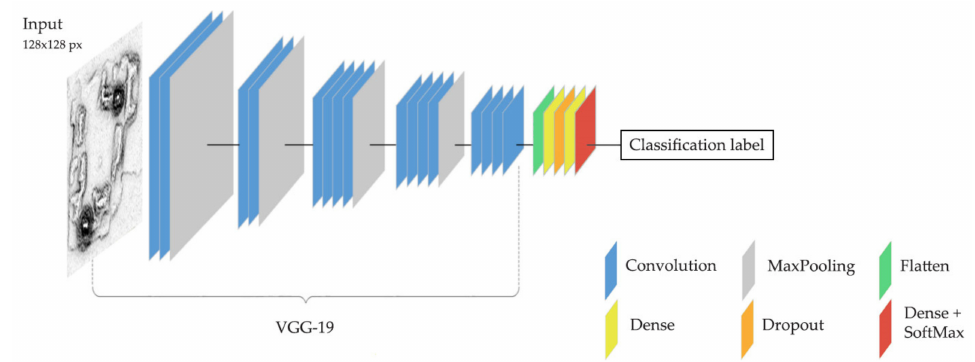
Figure 10. Architecture of our VGG-19 based CNN network, depicted with color-coded layers. The network accepts images of 128 by 128 pixels as inputs. The first part of the network, the part on the left, represents the VGG-19 architecture, which consists of multiple blocks of convolution layers (blue) and max pooling layers (gray). At the end of the VGG-19, we added five extra layers, including flatten layer (green), dense or fully connected layer (yellow), dropout layer (orange) and dense layer with softmax function (red). The output of the network is one of the four classification labels (aguada, building, platform or